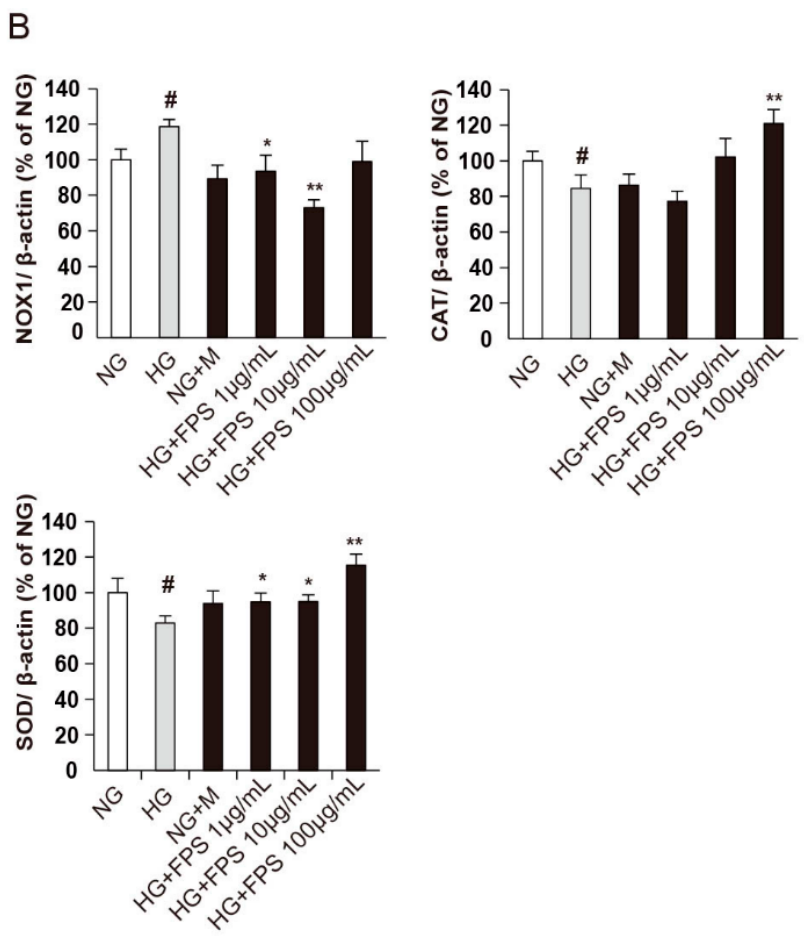
Figure 8. The effects of FPS on the expression of antioxidant enzymes and Nox1: ( A ) The protein expression levels were assayed by Western blotting; ( B ) The statistical data of protein were expressed by mean ± S.D. ( n = 3). ** p < 0.01; # or * p < 0.05; “#”, HG vs. NG; “*” or “**”, HG vs. HG + FPS. The ordinate is the percentage relative to NG group.